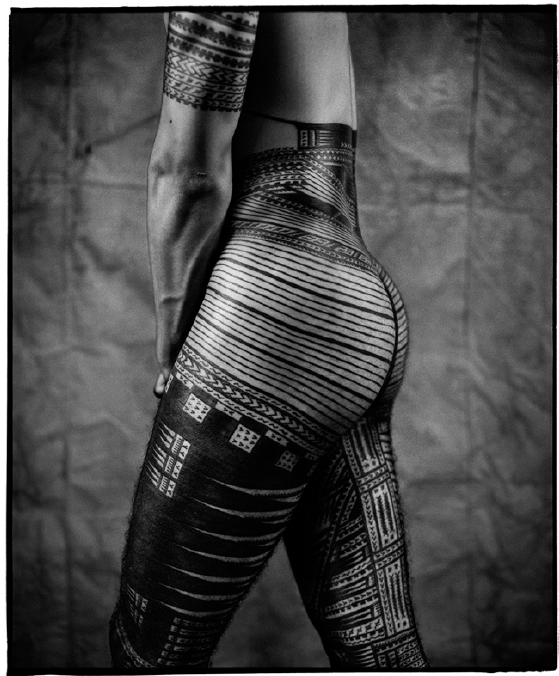
Figure 16. Self-portrait by Greg Semu of his pe’a , the traditional men’s tatau from Samoa. Image courtesy of the artist.